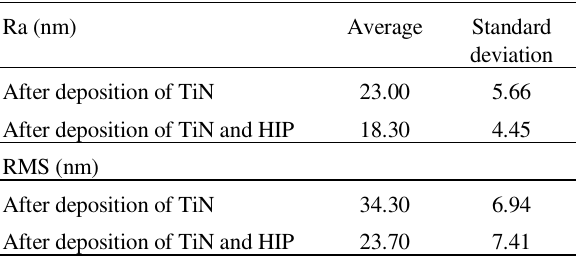
Table 1. Ra and RMS values determined by atomic force